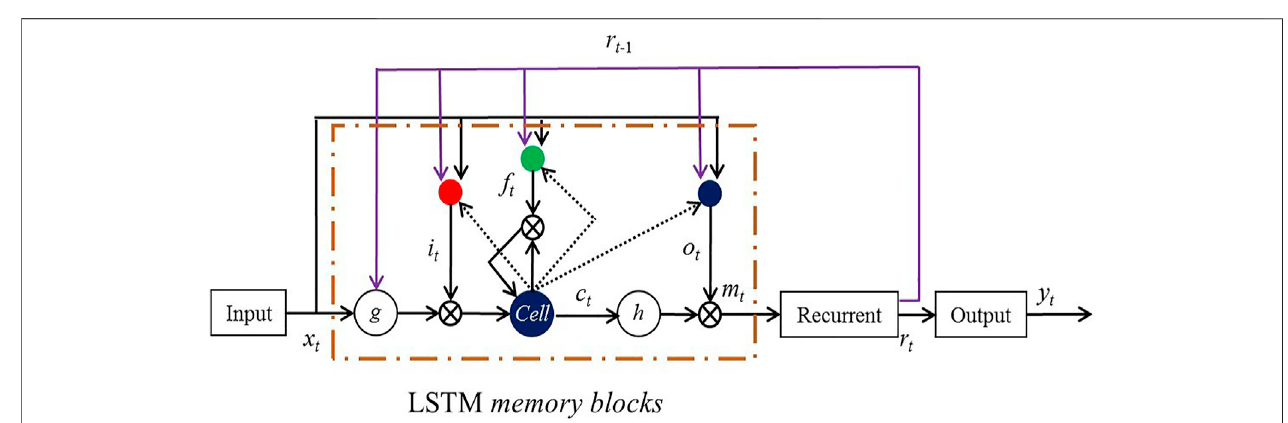
FIGURE 5 | Autocorrelation analysis of time-series wind direction data.